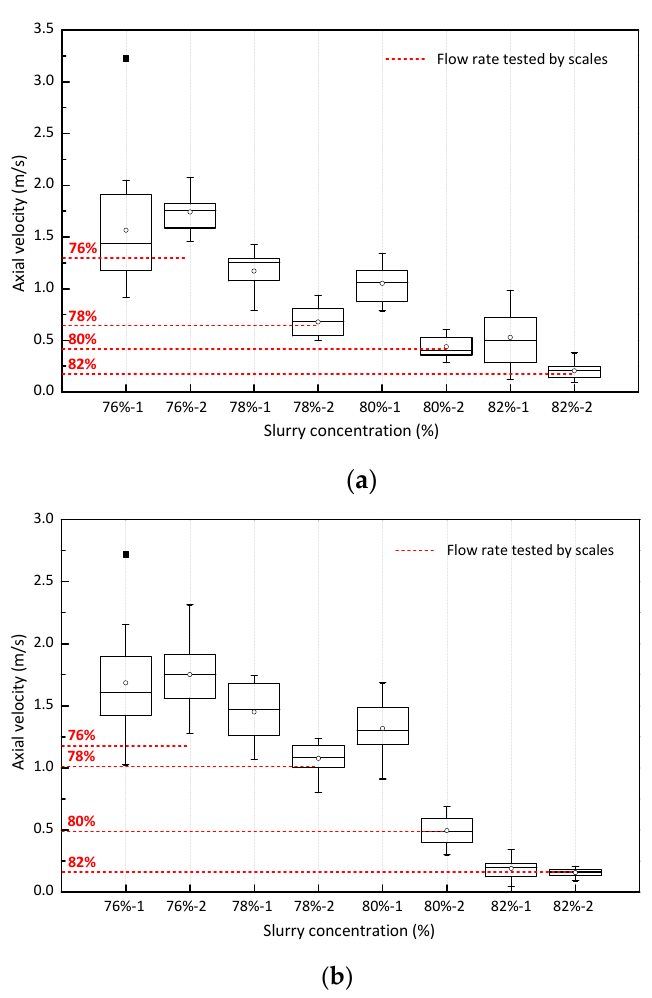
Figure 10. Boxplots of axial velocity tested using ERT. ( a ) S1 and ( b ) S2.